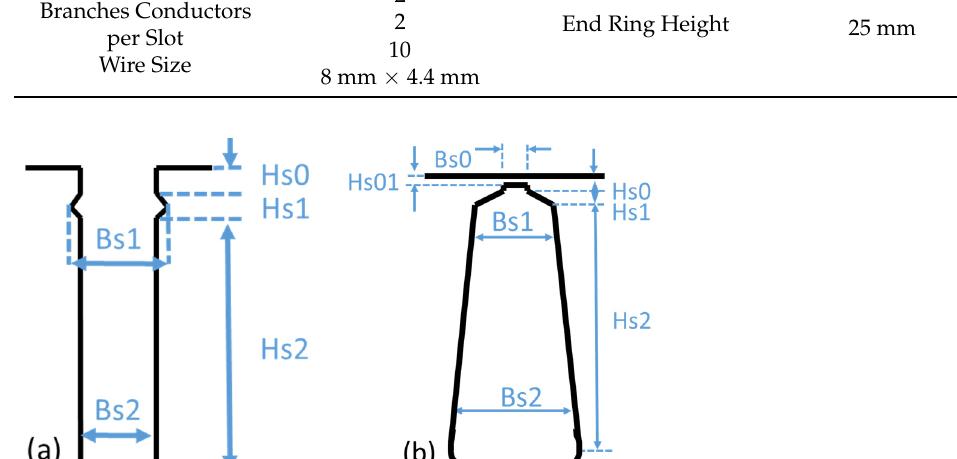
Figure 8. Ansys RMxprt model of medium voltage machine. With the results from RMxprt, a 2-dimensional (2D) FEA model of the medium-volt- age motor is created using the built-in function in ANSYS Maxwell. The cross section of the motor and a zoomed-in view of the stator slot is shown in Figure 9. Each stator slot has two copper stator windings (upper and lower) surrounded by an individual winding insulation. This is also called as stator groundwall insulation. The stator-ground wall in- sulation material was chosen as Mica. The properties of Mica used in the simulation have been listed in Table 2. Both the windings are separated by a space made of FR4 glass epoxy. The stator slot is closed by a wedge made of Polytetrafluoroethylene (PTFE). The geometry and material assignments of the different parts of the motor are listed in Table 3. Figure 9. 2D FEA model of the medium-voltage machine. Different parts of the motor are num- bered and listed in Table 3.